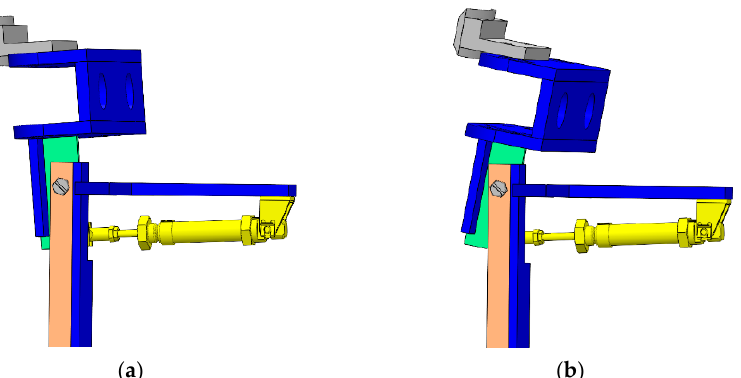
Figure 7. Obstacle avoidance mechanism. ( a ) Normal working conditions; ( b ) working conditions when passing obstacles.